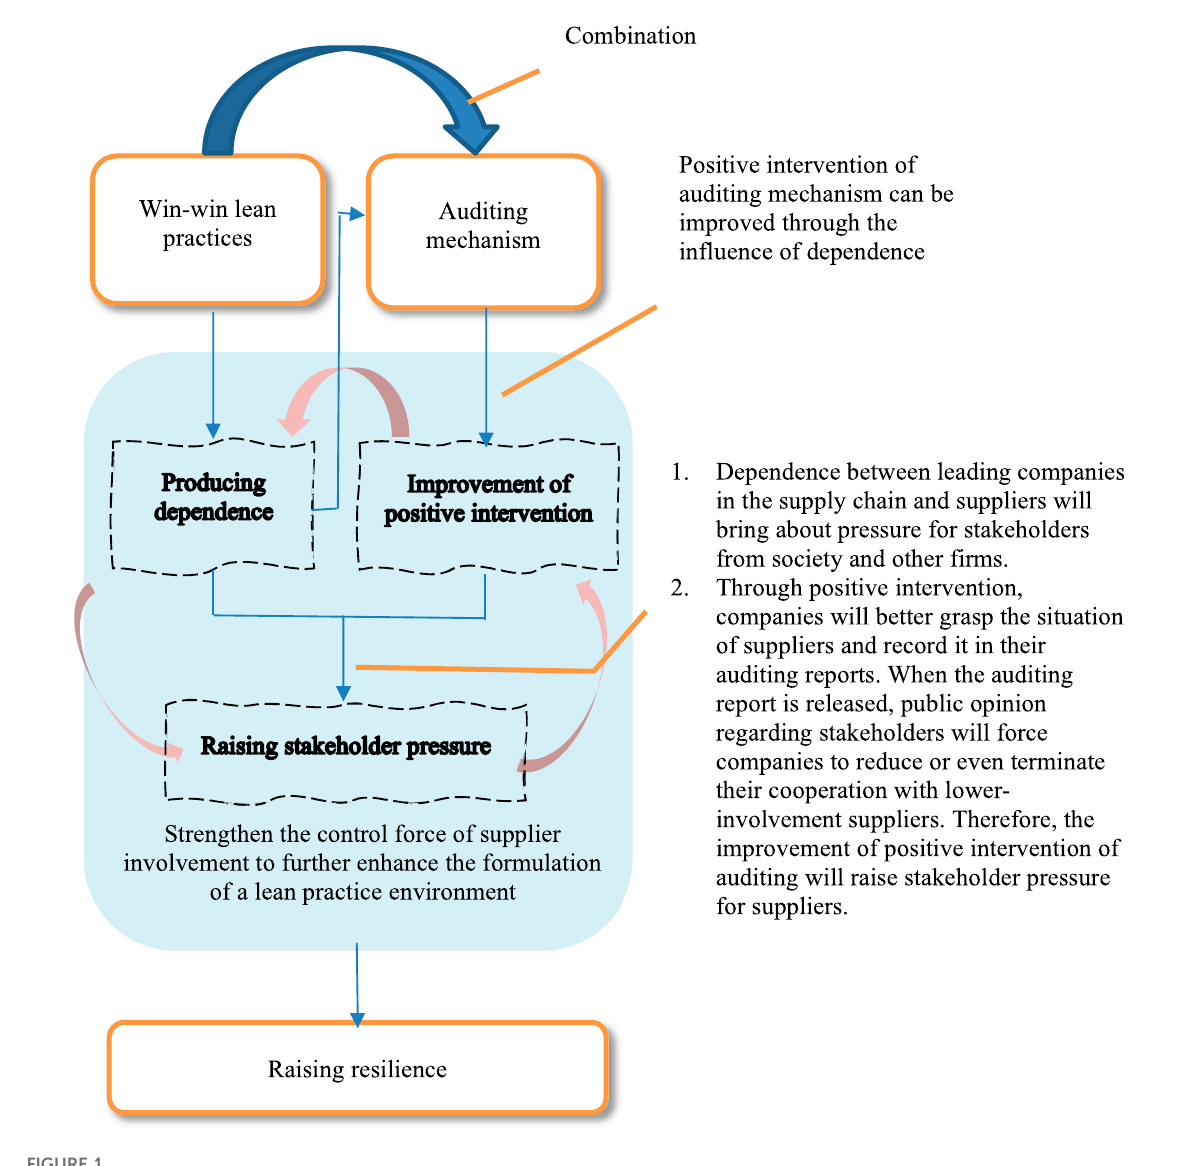
FIGURE 1 Framework and practice of the combination of win ‒ win lean practices and auditing